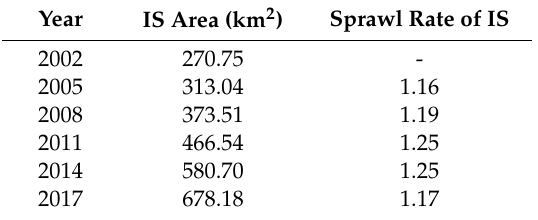
Table 4. Detailed information of impervious surfaces (IS) in the study area from 2002 to 2017. Year IS Area (km 2 ) Sprawl Rate of IS